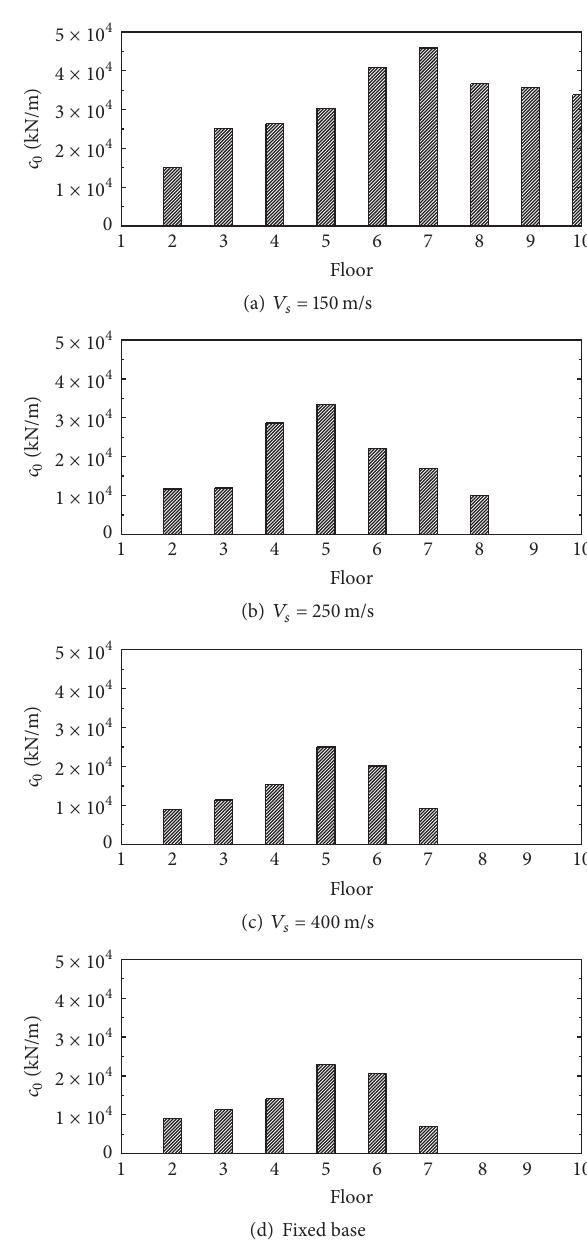
Figure 10: The mean reduction ratio for structures with various degrees of foundation embedment ratio (20-story structures). Figure 11: The optimal placement schemes of VEDs for different soil types (10-story structure, 𝐸/𝑅 = 1